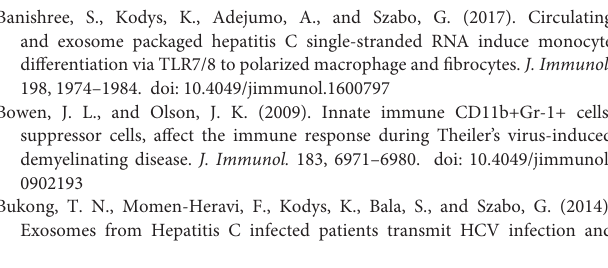
Supplementary Figure 3 | Efficiency of siRNA in bystander microglia. Microglia were transfected with siRNA for MyD88, TICAM-1, MAVS, or control for 6 h. Microglia were lysed, RNA isolated, converted to cDNA, and analyzed by real time PCR for expression of MyD88 (control siRNA and MyD88 transfected microglia), Ticam-1 (control siRNA and Ticam-1 transfected microglia), or MAVS (control siRNA and MAVS transfected microglia). The percent expression was calculated for each primer pair based on the expression in control siRNA transfected microglia for that primer (100% expression). Supplementary Table 1 | Protein analysis in identification of